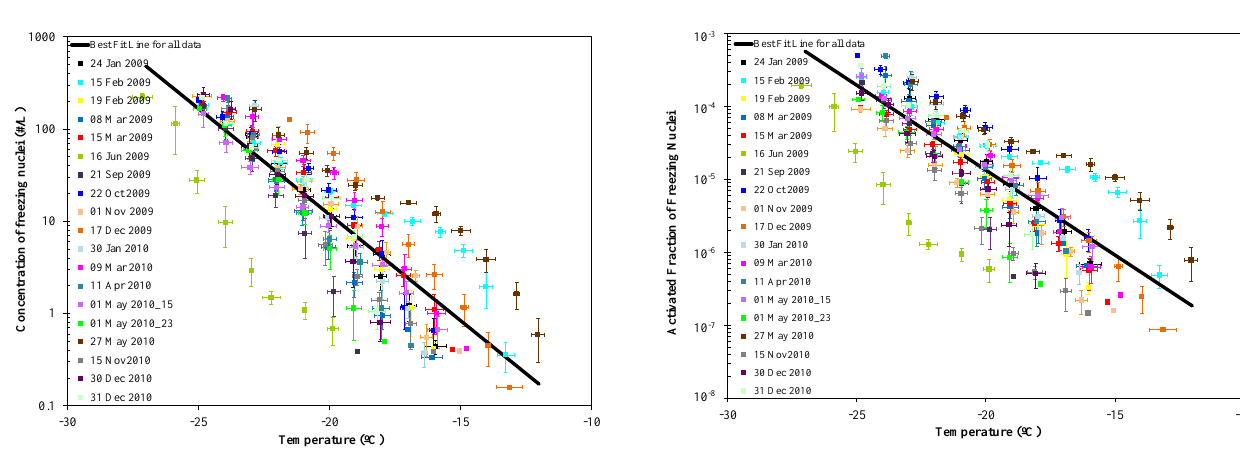
Figure 4. The concentrations of FN using the different filters. The bars represent the standard deviation and the black line is the best- fit line representing all the data. Please note the significantly low values of the measurements during the Lag BaOmer bonfires at 23:00LT (green squares).